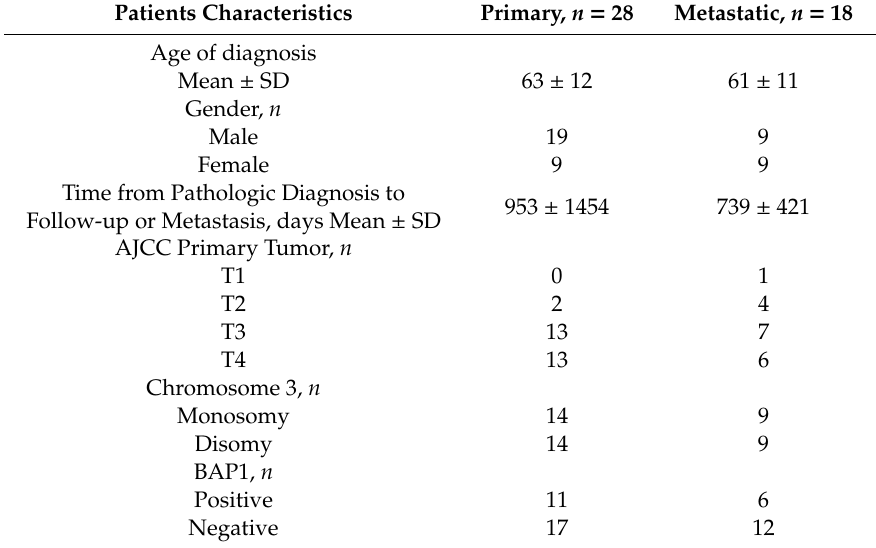
Table 3. The clinical, histopathological, and molecular characteristics of distinguished subgroups of studied primary tumor samples collected from uveal melanoma (UM). SD: Standard